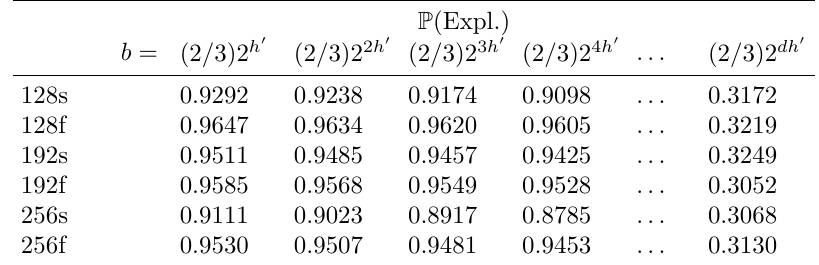
Table 11: Analysis of the branch caching countermeasure for all SPHINCS + parameter sets. The numbers b are rounded up to the next